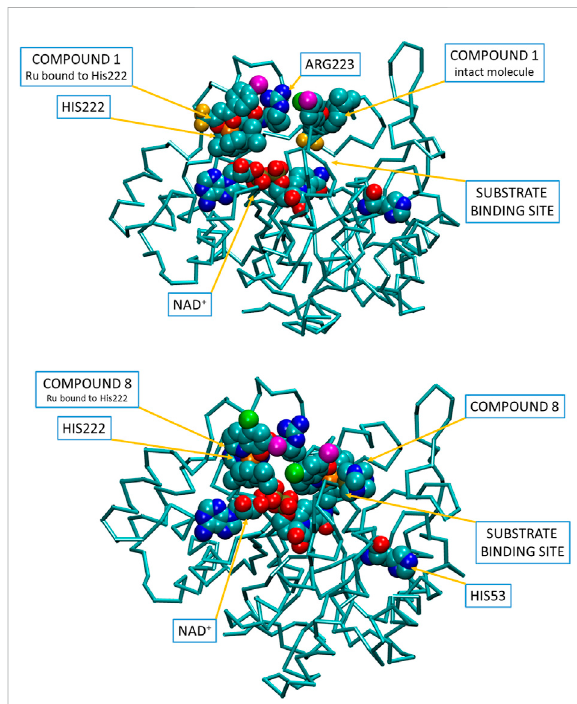
Visualization of a putative binding of two molecules of compounds 1 and 8 into the open conformation of holo-AKR1C1, corroborating the proposed reaction scheme shown in Figure 4. Inhibitor and substrate molecules are depicted in space fi ll (carbon — cyan, oxygen — red, nitrogen — blue, fl uorine — yellow, iodine — purple, chlorine — green, ruthenium — orange, phosphorus — pale yellow). Video visualizations of molecular dynamics simulations of binding of compounds 1 and 8 can be found as Supplementary